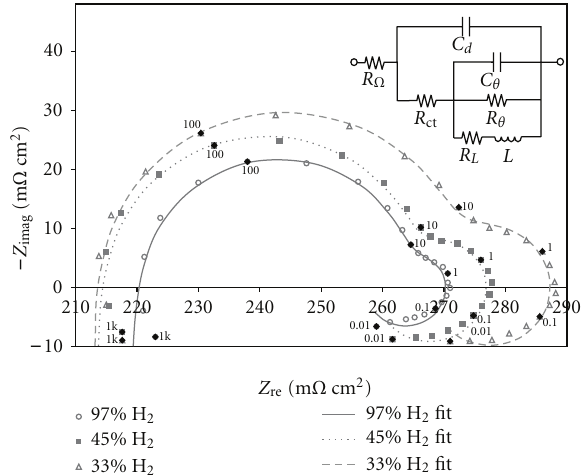
Figure 1: Nyquist plot for a button cell anode operating at 800 ◦ C and 175 mAcm − 2 and fed with 3% H 2 O and H 2 diluted with varying amounts of N 2 . Data fits were obtained with the anode equivalent circuit model in the right-hand corner of the figure.